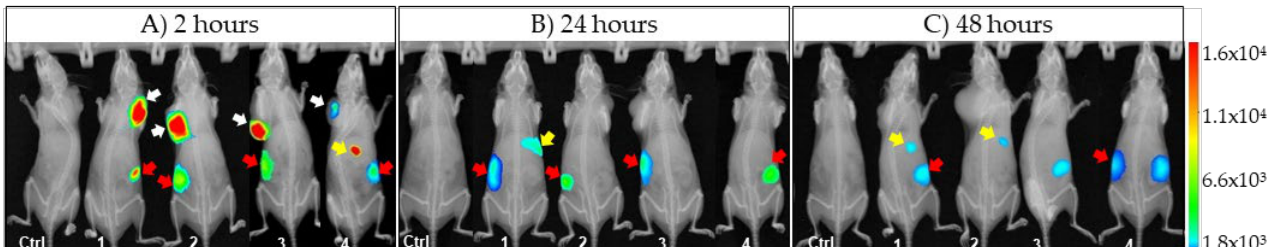
Figure 1. Images acquired post-injection of Sgc8-c-Alexa647: arrows indicate fluorescent signals detected in vivo (white = tumors; yellow = liver and gallbladder; red = kidneys). Aptamer probe injected mice (1, 2, 3 and 4) and PBS injected mice (Ctrl).